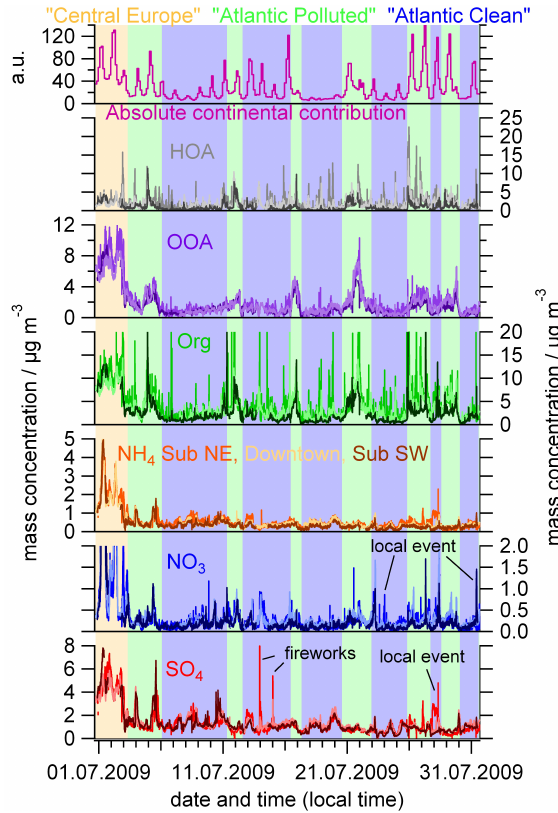
Fig. 4. Classification of the sampled air masses (orange, green, and blue background for “Central Europe”, “Atlantic Polluted”, and “At- lantic Clean” air masses, respectively), time series of calculated ab- solute continental contribution to footprint emission sensitivity , and selected species (SO 4 , NO 3 , NH 4 , organics, and OOA and HOA retrieved from total organics using PMF) measured with the AMS at the three stationary sites (Sub NE: medium coloured, Downtown: light coloured, Sub SW: dark coloured curves). Some local events at single sites in the time series of NO 3 and SO 4 as discussed in Sect. 3.3.1 are marked.